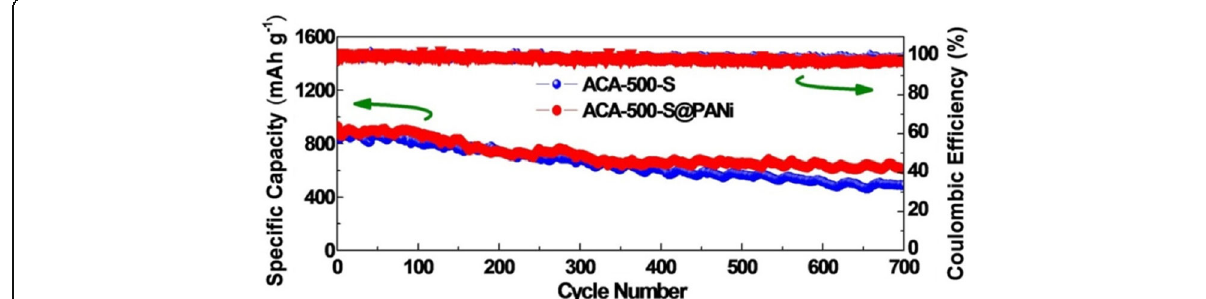
Fig. 7 Cycle performance of ACA-500-S and ACA-500-S@PANi cathodes at